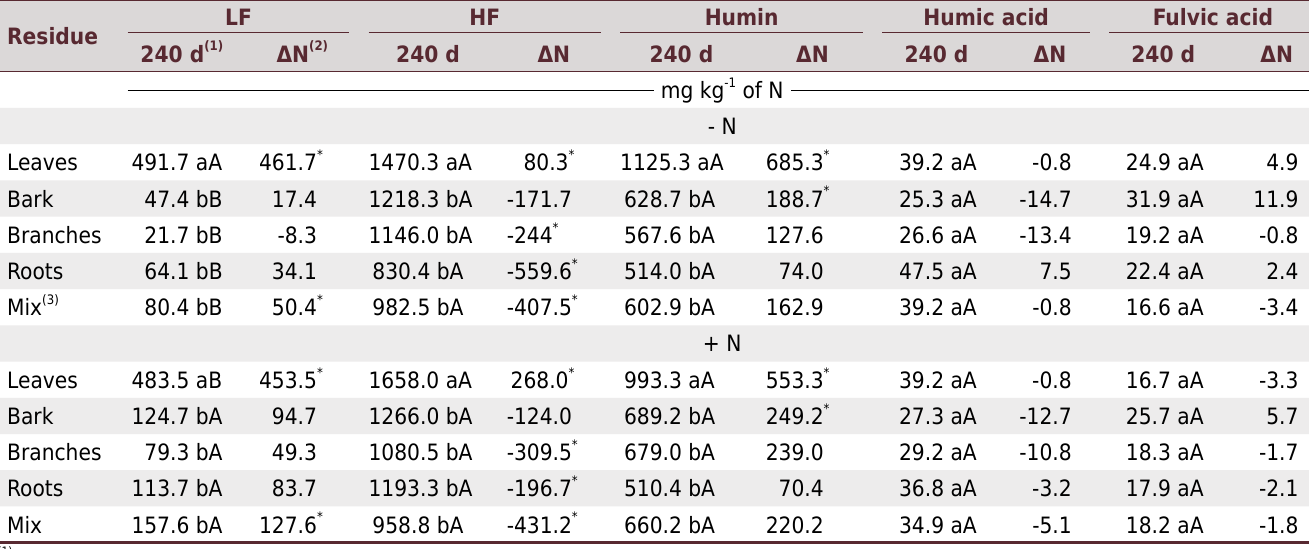
(1) For each SOM fraction, lowercase letters compare different Eucalyptus residues and uppercase letters compare the effect of addition of mineral N according to the Tukey test (p<0.004). Values are means of four replicates. (2) Variation in the amount of each SOM fraction 240 days after setting up the experiment (ΔN = N final -N initial ). The values marked with an asterisk represent a significant increase or decrease compared to the control soil (p<0.004). (3) Mixture of leaves, bark, branches, and roots at the relative proportions of 12.9, 26.4, 12.7, and 49 %, respectively. LF: light fraction of SOM, HF: heavy fraction of